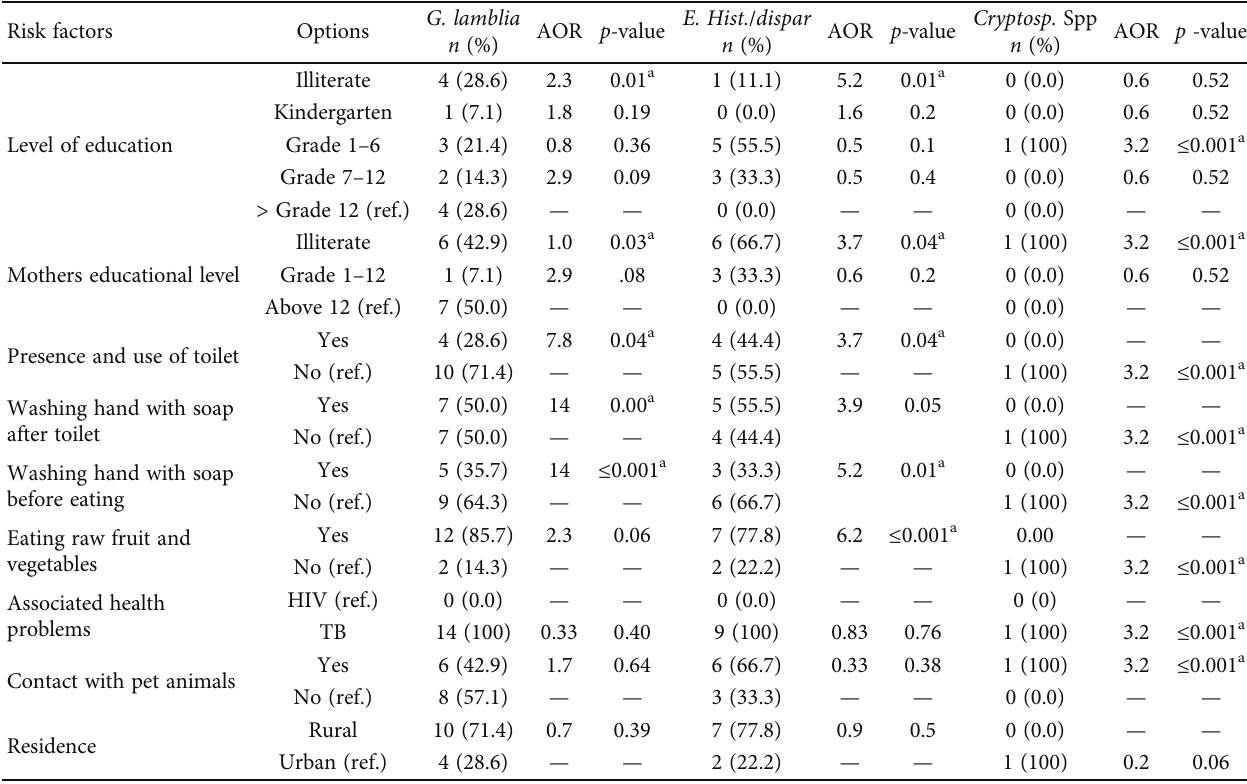
Table 6: Multivariate logistic regression analysis for the associated risk factors of intestinal protozoal parasitic infection among positive diarrheal patients (cases) attending Negelle General